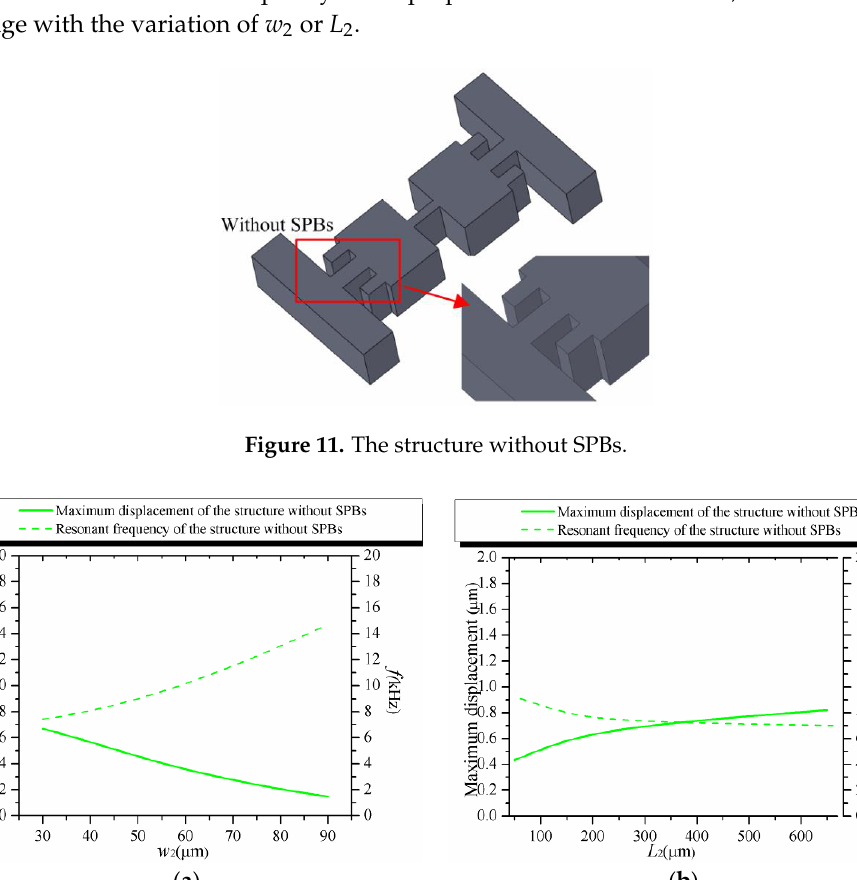
Figure 12. The maximum displacement and the resonant frequency of the structure without the SPBs. ( a ) The effect of w 2 ; ( b ) The effect of L 2 .